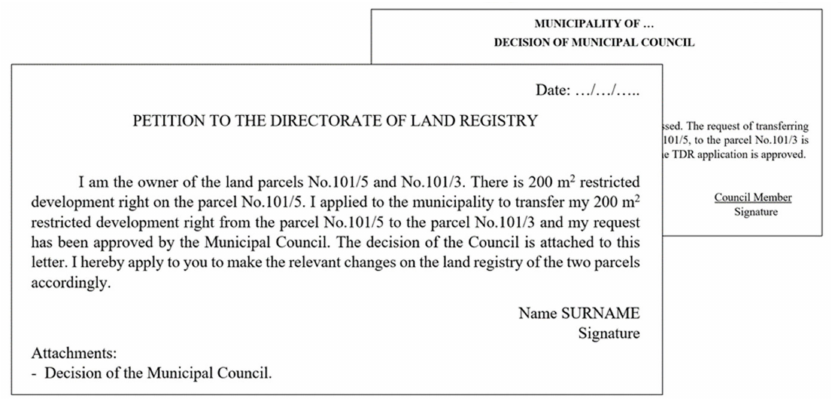
Figure 13. Landowner’s application to land registry office for the update in land